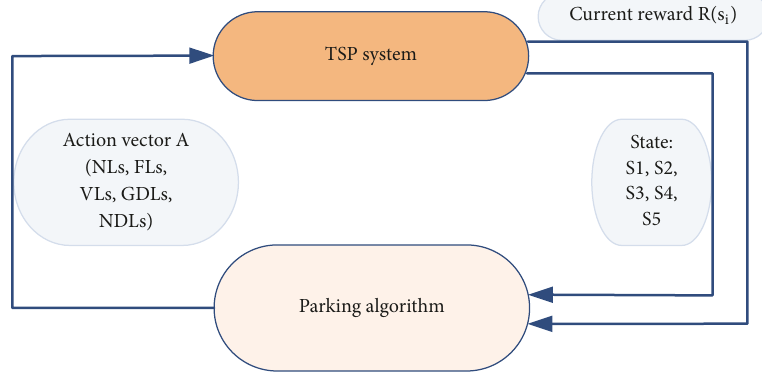
Figure 3: Diagram of state, reward, and action